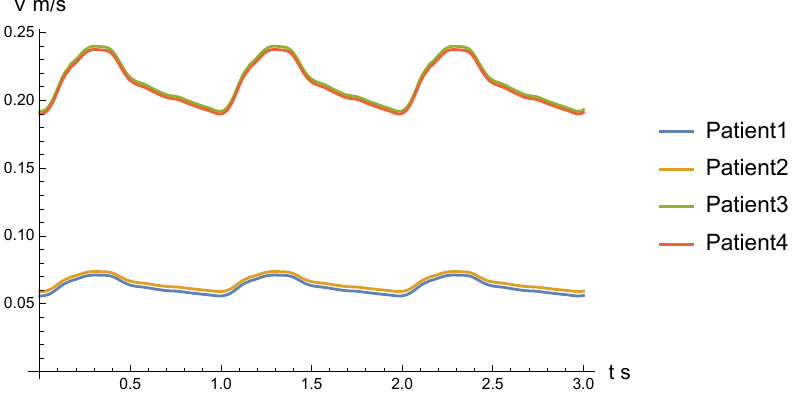
Figure 5. Velocity profiles applied at the inlets for all patients (patients 1,2-profiles for ICA, patients 3, 4-profiles for MCA). The volumetric distribution of blood flow in the cerebral vessels for scaling in relation to patients without intraoperative measurements was carried out on the data from